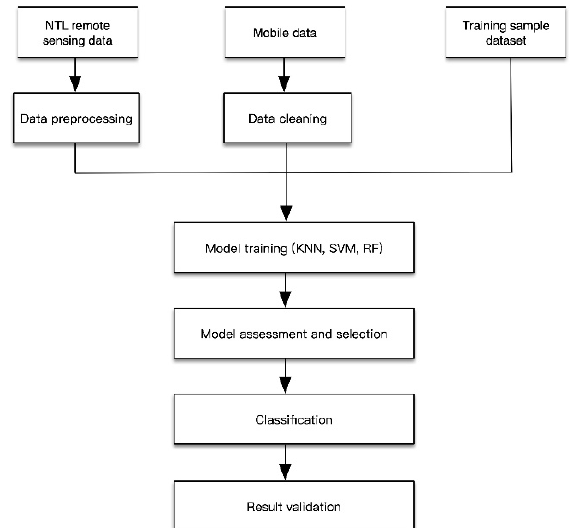
Figure 4. Process of recognition of urban functional regions